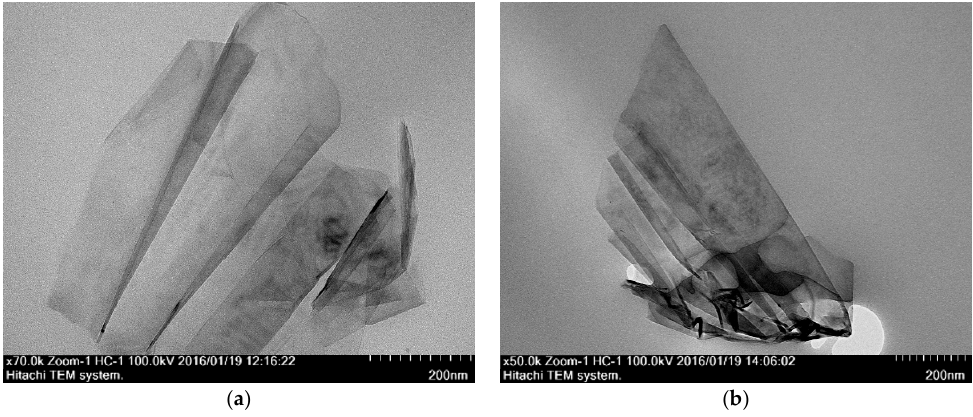
Figure 15. Cross section TEM images of nanocomposites prepared by solution blending with different RGO loading. ( a ) 0.5 wt % RGO loading; ( b ) 2.0 wt % RGO loading.